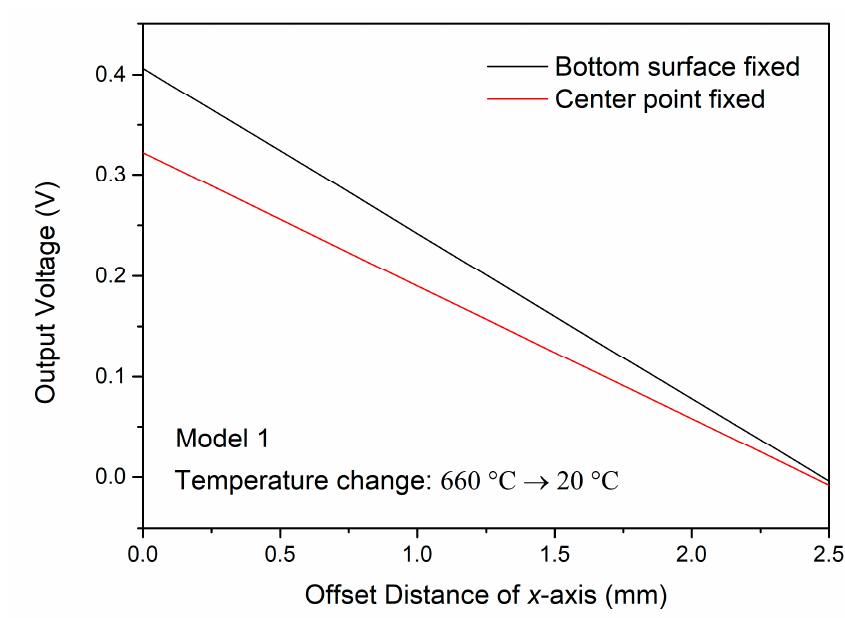
Figure 9. Relationships between the output voltage for the composite (Model 1) due to the concentrated load and the offset distance along the x axis ( z = 0 mm).